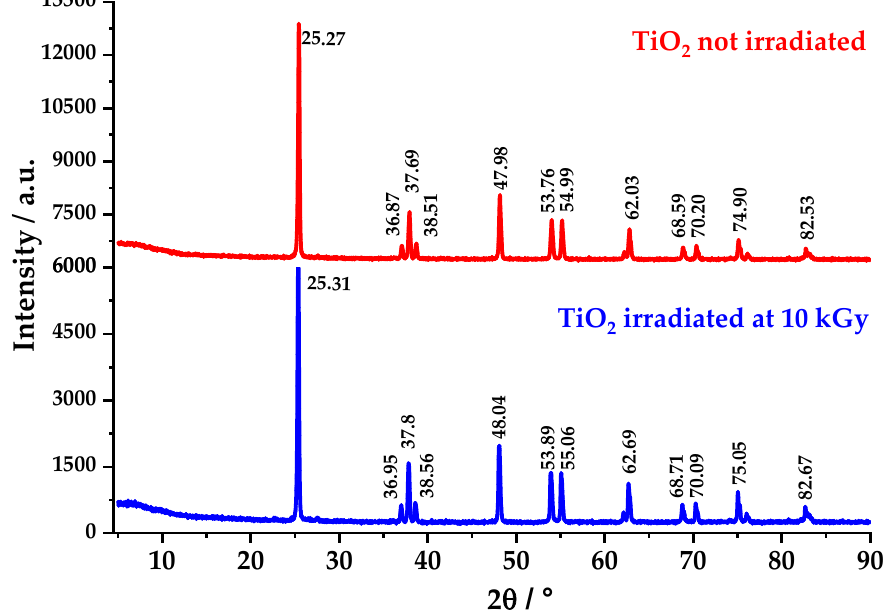
Figure 3. TiO 2 X-ray diffraction with and without irradiation.